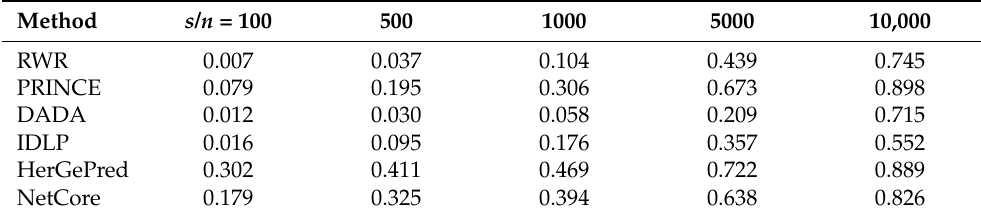
Table 6. Recall values evaluated by prediction scores for disease-gene association prediction with known disease genes from